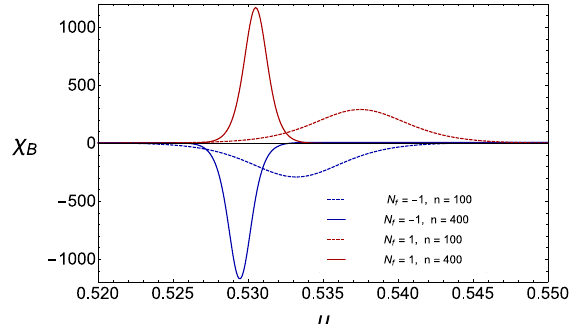
Figure 5 . The baryon number susceptibility near the critical point for (cid:22) n = n = 100 (dashed) and (cid:22) n = n = 400 (solid) both for the bosonic 9 (blue) and the fermionic partition function. Up to a minus sign, which could have been absorbed by the de(cid:12)nition of the bosonic baryon number susceptibility, the results are similar and appear to approach the same limit (up to a minus sign) for n !